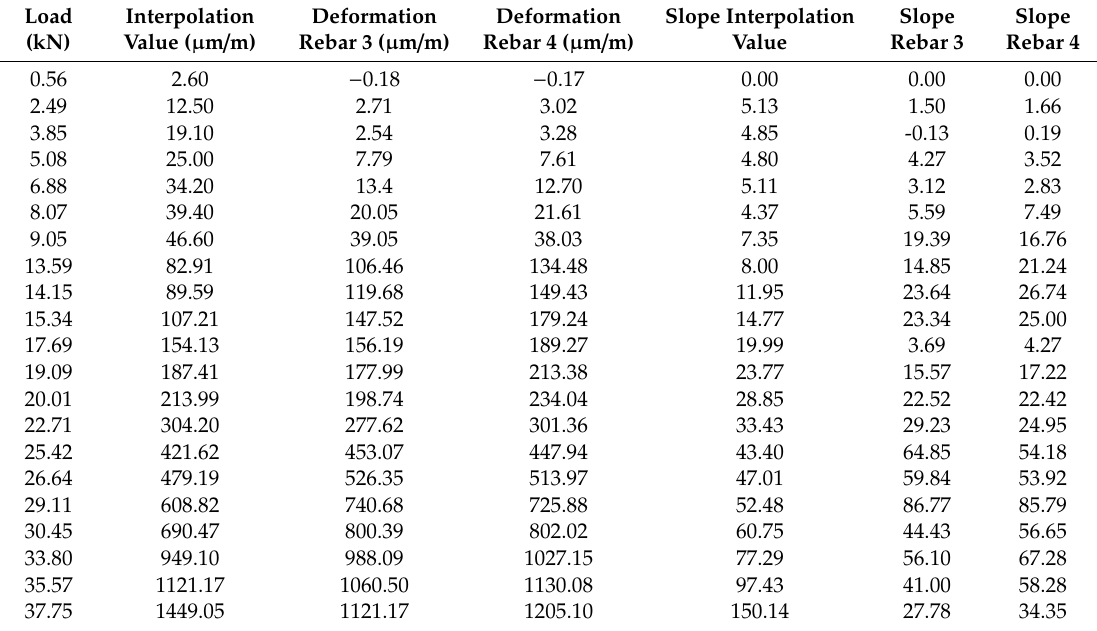
Table 6. Slope values of the theoretical deformation curves and of rebars 3 and 4.